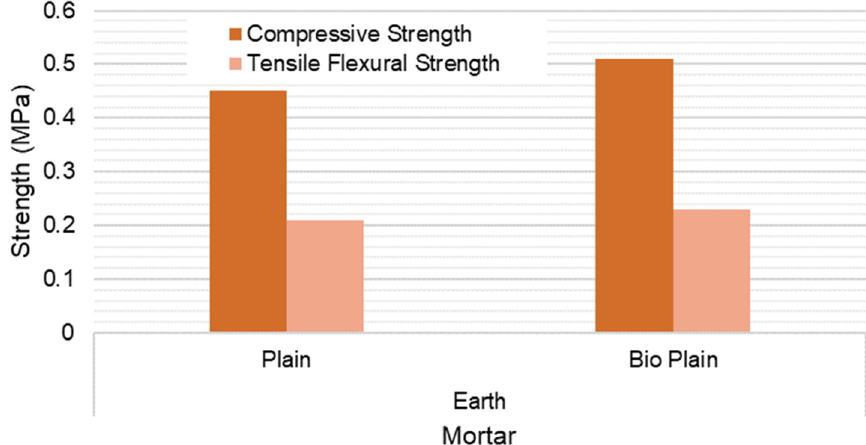
Figure 19. Compressive and tensile flexural strength at 28 days for the earth-based mortar with and without biostabiliser. Coefficient of variation for tensile flexural strength (CoV) per family of mortar: earth mortar: 23.4%; earth+bio: 14.0%. Coefficient of variation for compressive strength (CoV) per family of mortar: earth mortar: 16.6%; earth+bio: 11.2%.